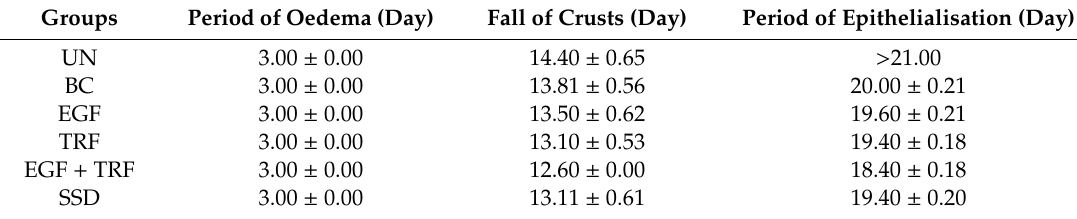
Table 2. Clinical evaluations of wounds in all the groups during the healing process.